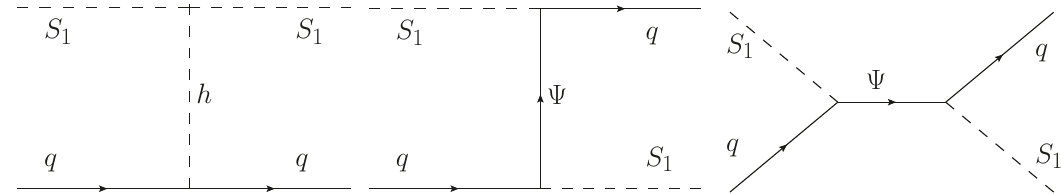
Figure 14. Spin independent elastic scattering between dark matter ( S 1 ) and